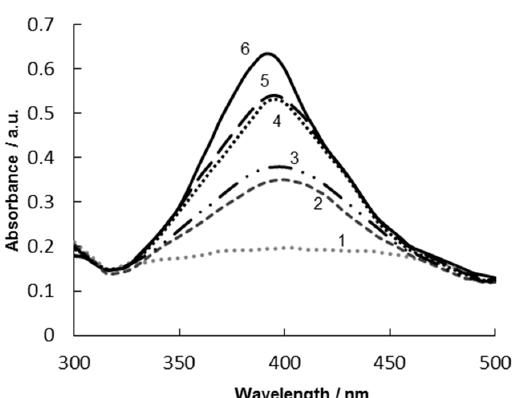
Figure 4. UV / Vis absorption spectra of Ag NPs 6 and after NaCl addition 1–5 and subsequent centrifugation in the presence of di ff erent concentrations of BSA: 1 —2 µ g · mL − 1 , 2 —4 µ g · mL − 1 , Figure 4. UV/Vis absorption spectra of Ag NPs 6 and after NaCl addition 1–5 and subsequent 3 —8 µ g · mL − 1 , 4 —16 µ g · mL − 1 , 5 —32 µ g · mL − 1 ; optical path length of 1.0 cm, blank—deionized water. centrifugation in the presence of different concentrations of BSA: 1 —2 µg·mL − 1 , 2 —4 µg·mL − 1 , 3 —8 µg·mL − 1 , 4 —16 µg·mL − 1 , 5 —32 µg·mL − 1 ; optical path length of 1.0 cm, blank—deionized water.